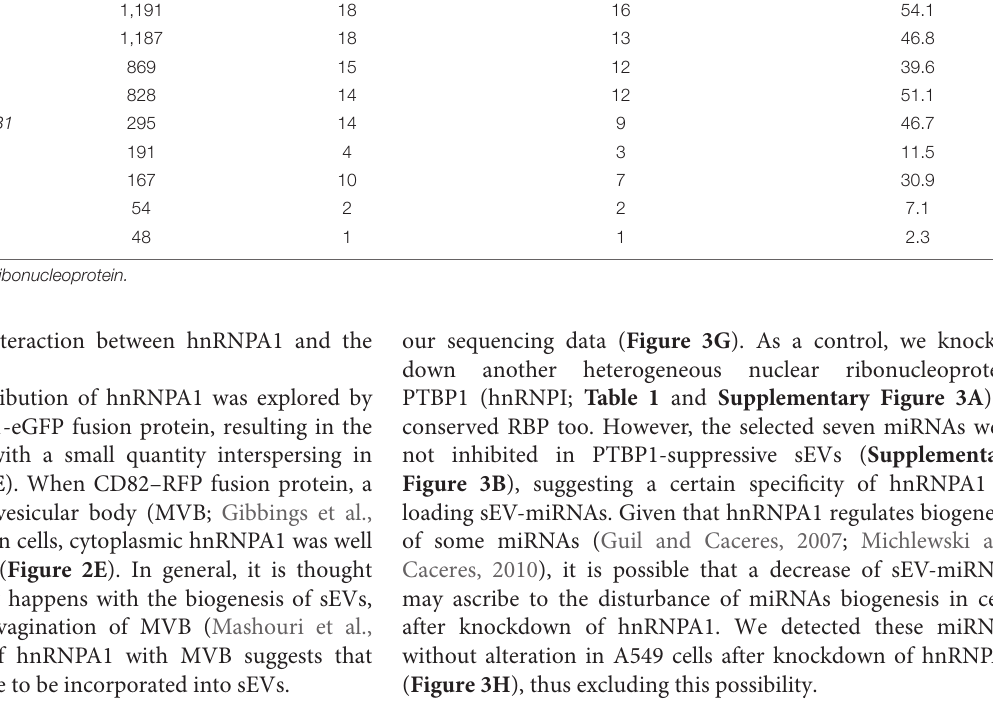
TABLE 1 | HnRNP family proteins co-precipitated with miR-320b by mass spectrometry analysis. UniProt